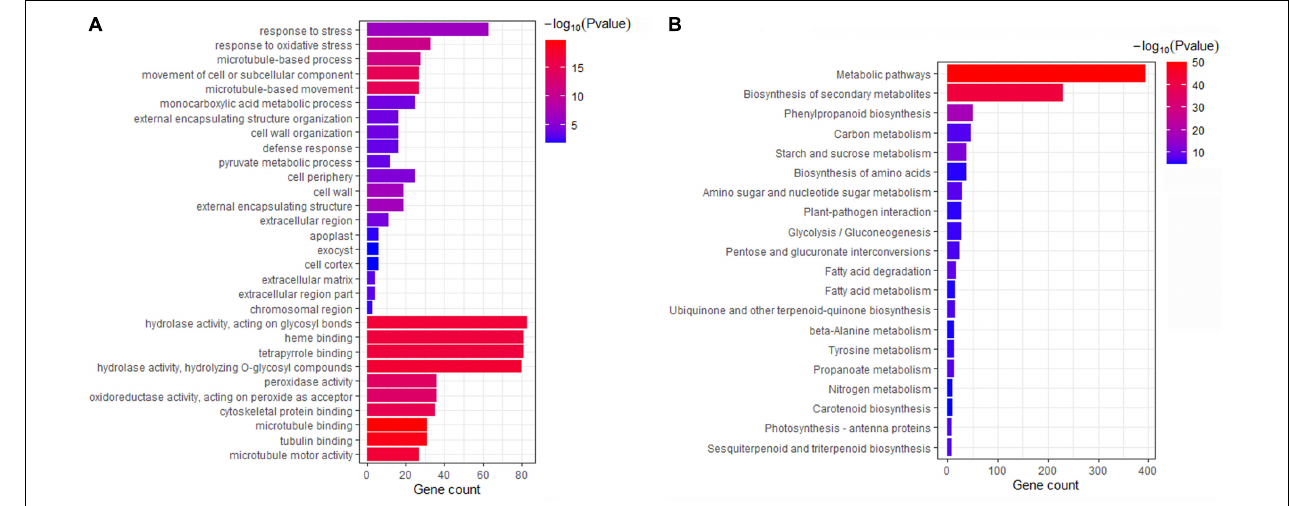
FIGURE 2 | Functional analysis of 3254 DEGs. (A) GO enrichment of DEGs. (B) KEGG enrichment of